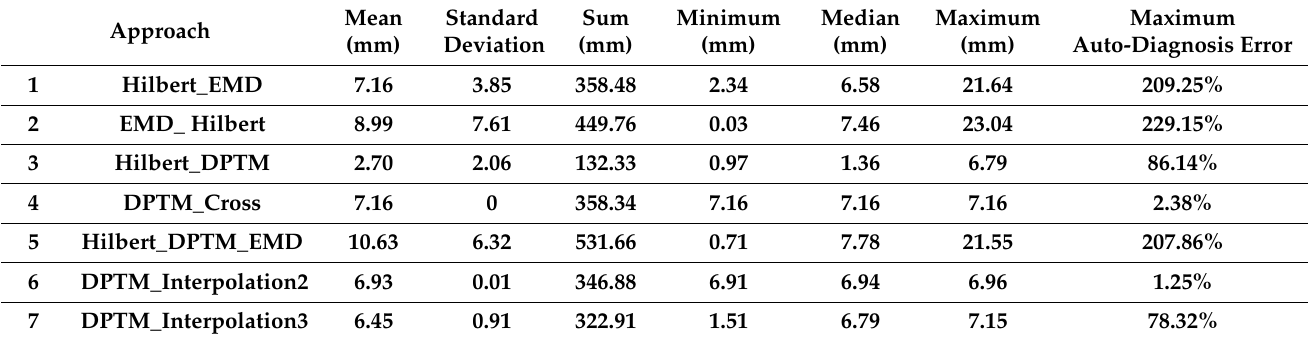
Table 2. Comparisons of results in a pipeline obtained using different approaches.